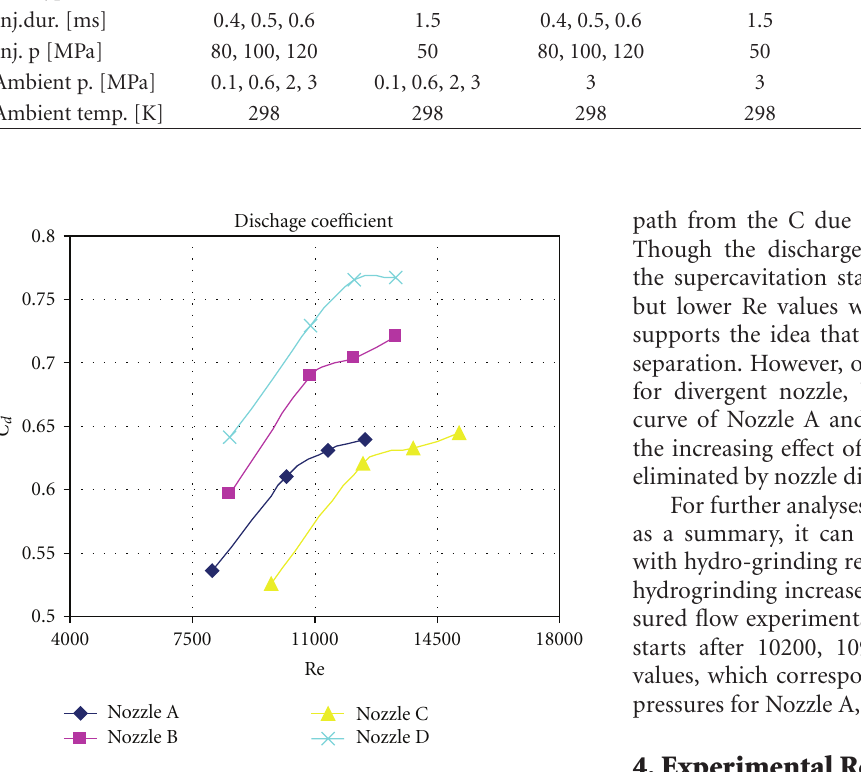
Figure 7: The discharge coe ffi cient